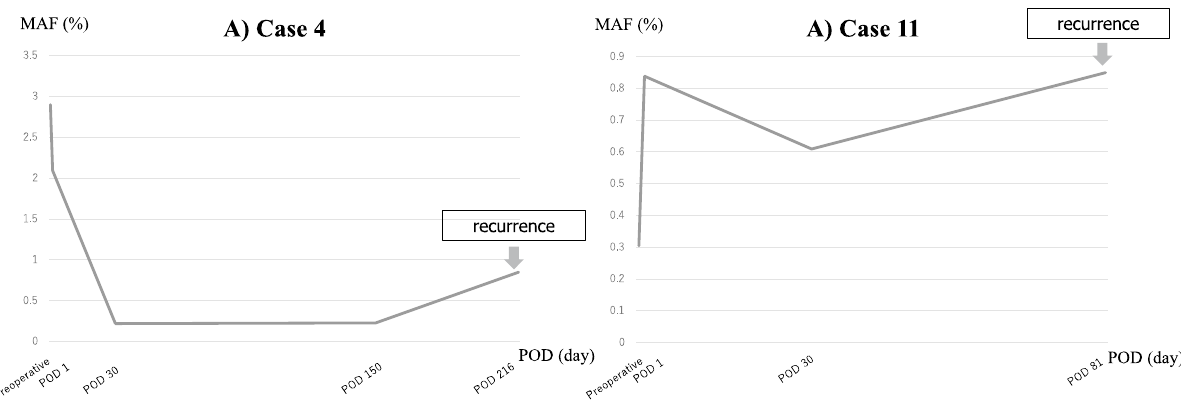
Figure 5. The mutant allele frequency of the BRAF V600E mutation was assessed in Case 4 and 11 until recurrence. In both cases, the cfDNA levels tended to increase over time. POD postoperative